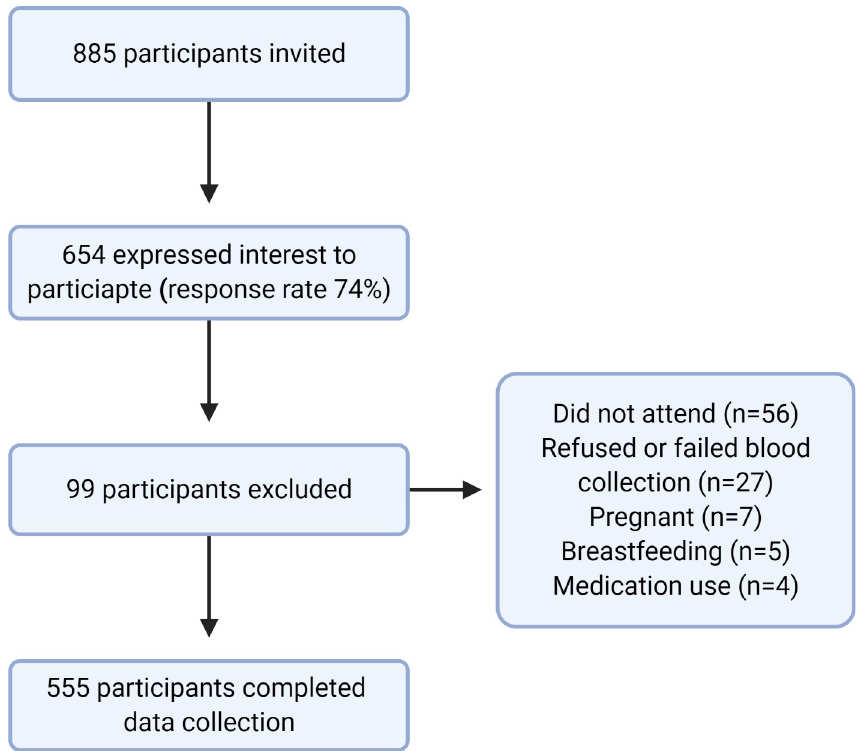
Fig 1. Flow chart of study